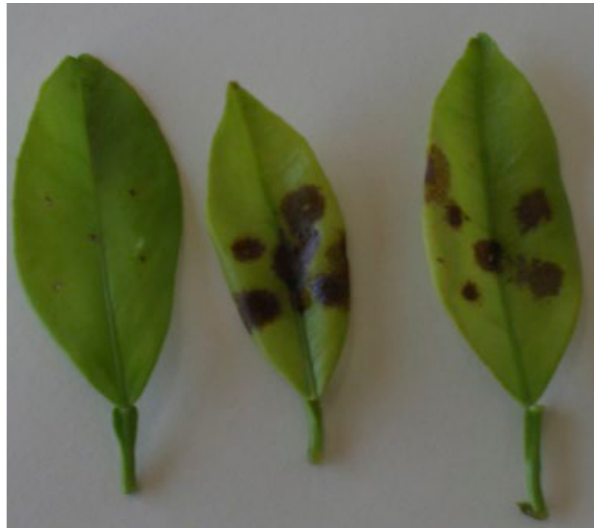
Figure 3. Necrotic lesions caused by Colletotrichum gloe- osporioides on artificially inoculated orange leaves (injured/ drop method) after 48 hours of incubation. Control leaf on the